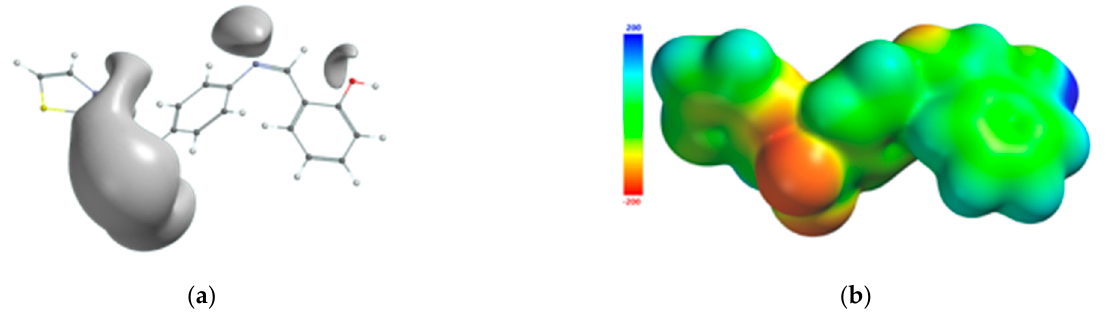
Figure 10. Isosurface of the molecular electrostatic potential of the Schiff base ligand ( a ); molecular electrostatic potential mapped on the surface of the total charge density ( b ).